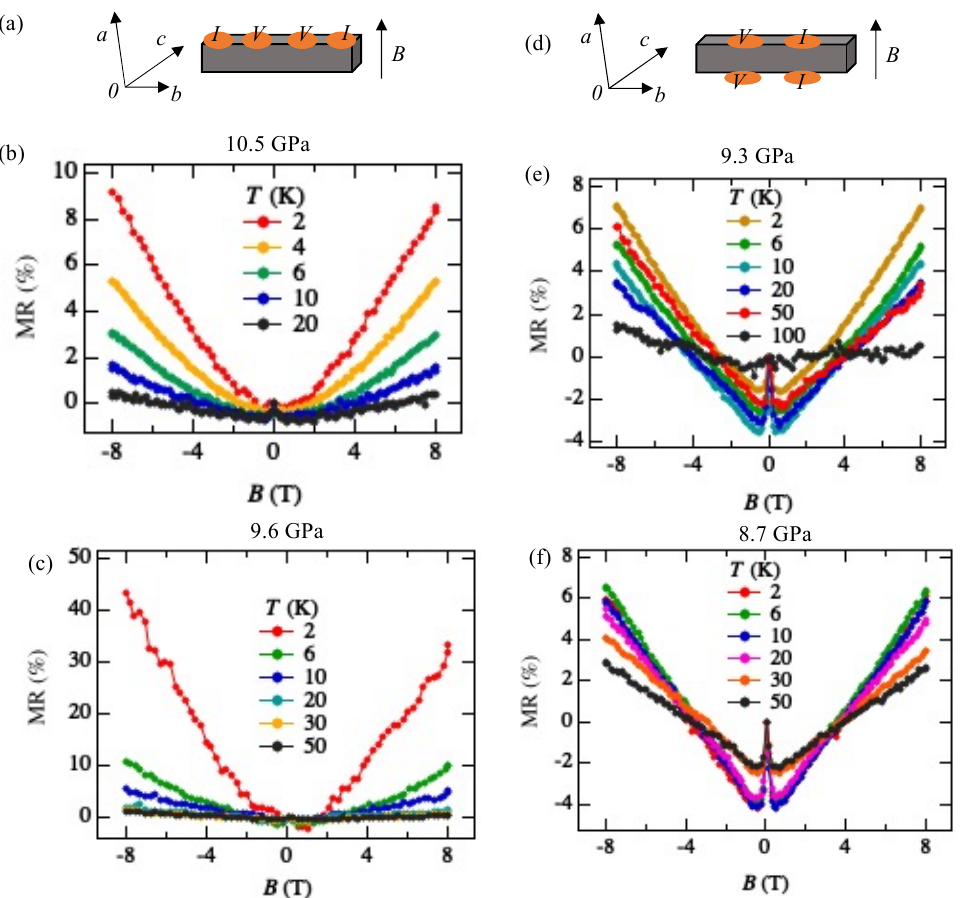
Figure 11. ( a ) Schematic of the crystal shape, axes and orientation of the four-probe attachment on Samples 7 and 8, in which the magnetic field ( B ) is perpendicular to the current direction. ( b ) Temperature ( T ) dependence of magnetoresistance (MR) as a function of B at 10.5 GPa (Sample 8). ( c ) Temperature dependence of MR as a function of B at 9.6 GPa (Sample 7). ( d ) Schematic of the crystal shape, axes and the orientation of the four-probe attachment on Sample 9, in which the magnetic field is parallel to the current direction. ( e ) MR as a function of B and T at 9.3 GPa (Sample 9). ( f ) MR as a function of B and T at 8.7 GPa (Sample 9).